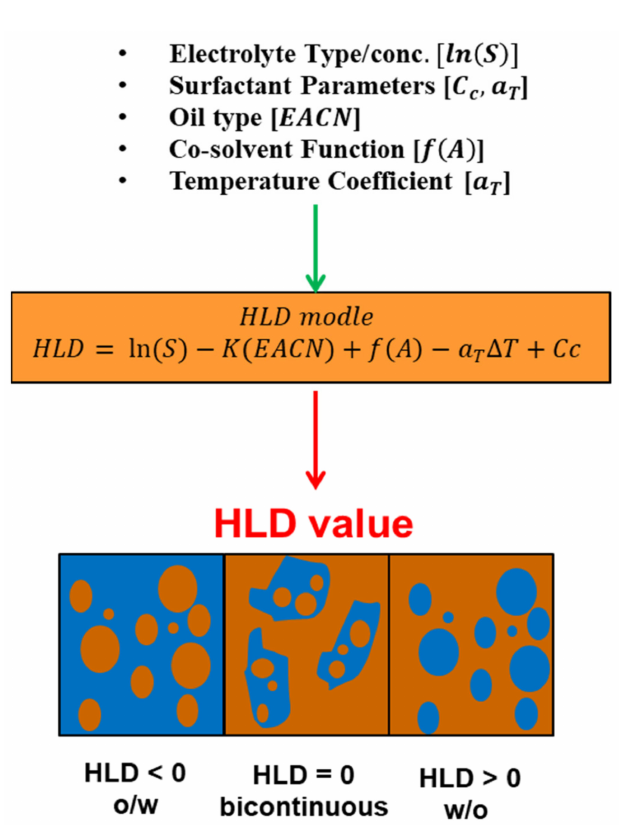
Figure 15. Inputs and outputs of HLD